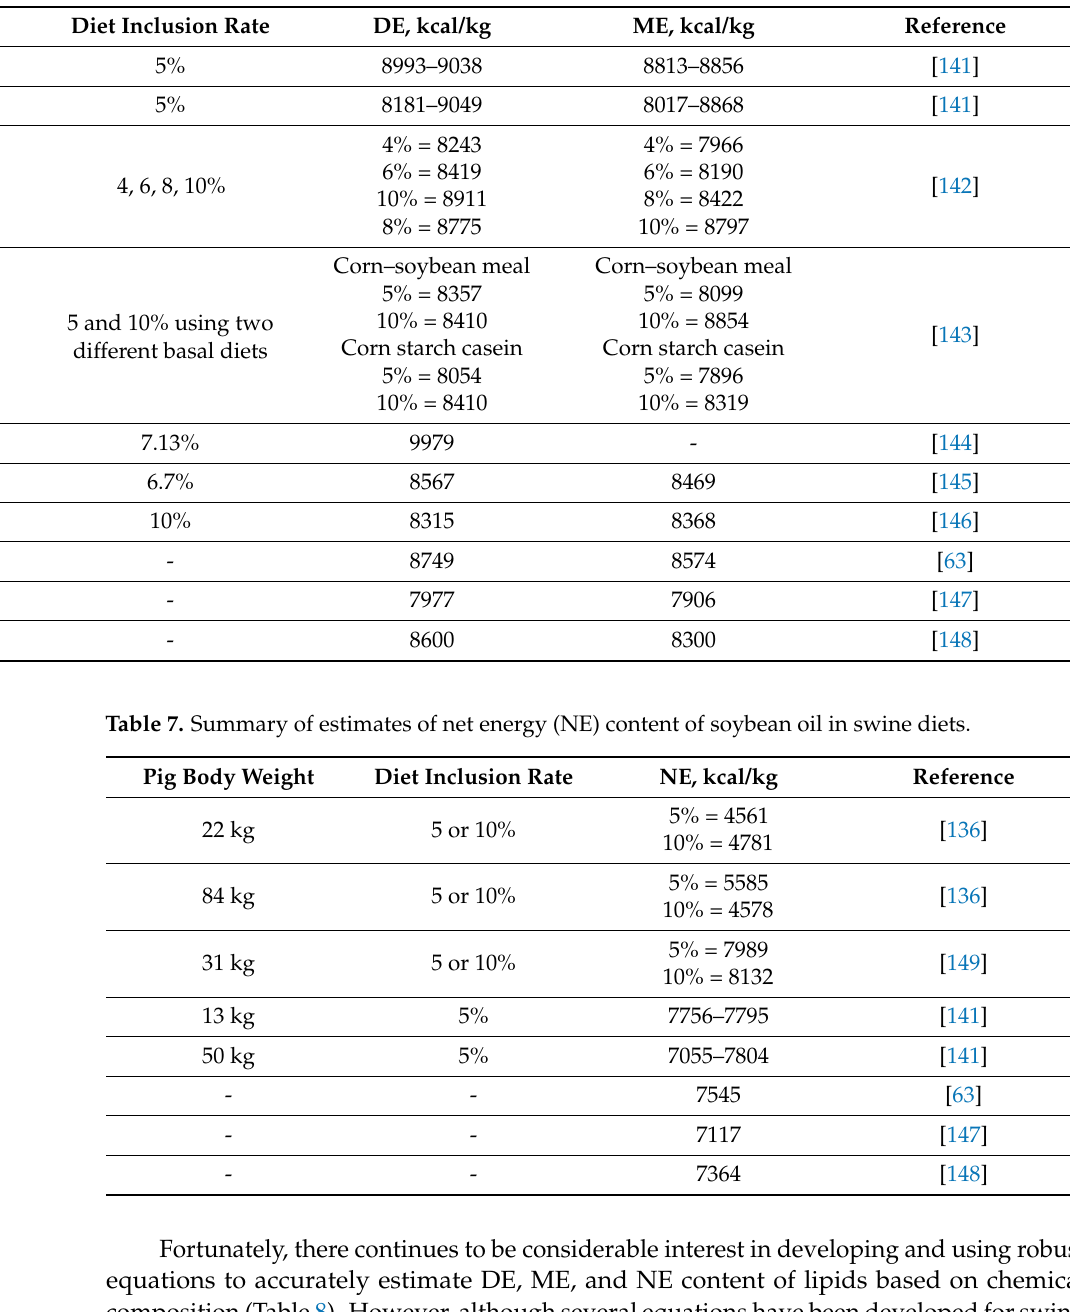
Table 6. Summary of published estimates of digestible energy (DE) and metabolizable energy (ME) content of soybean oil in swine diets.